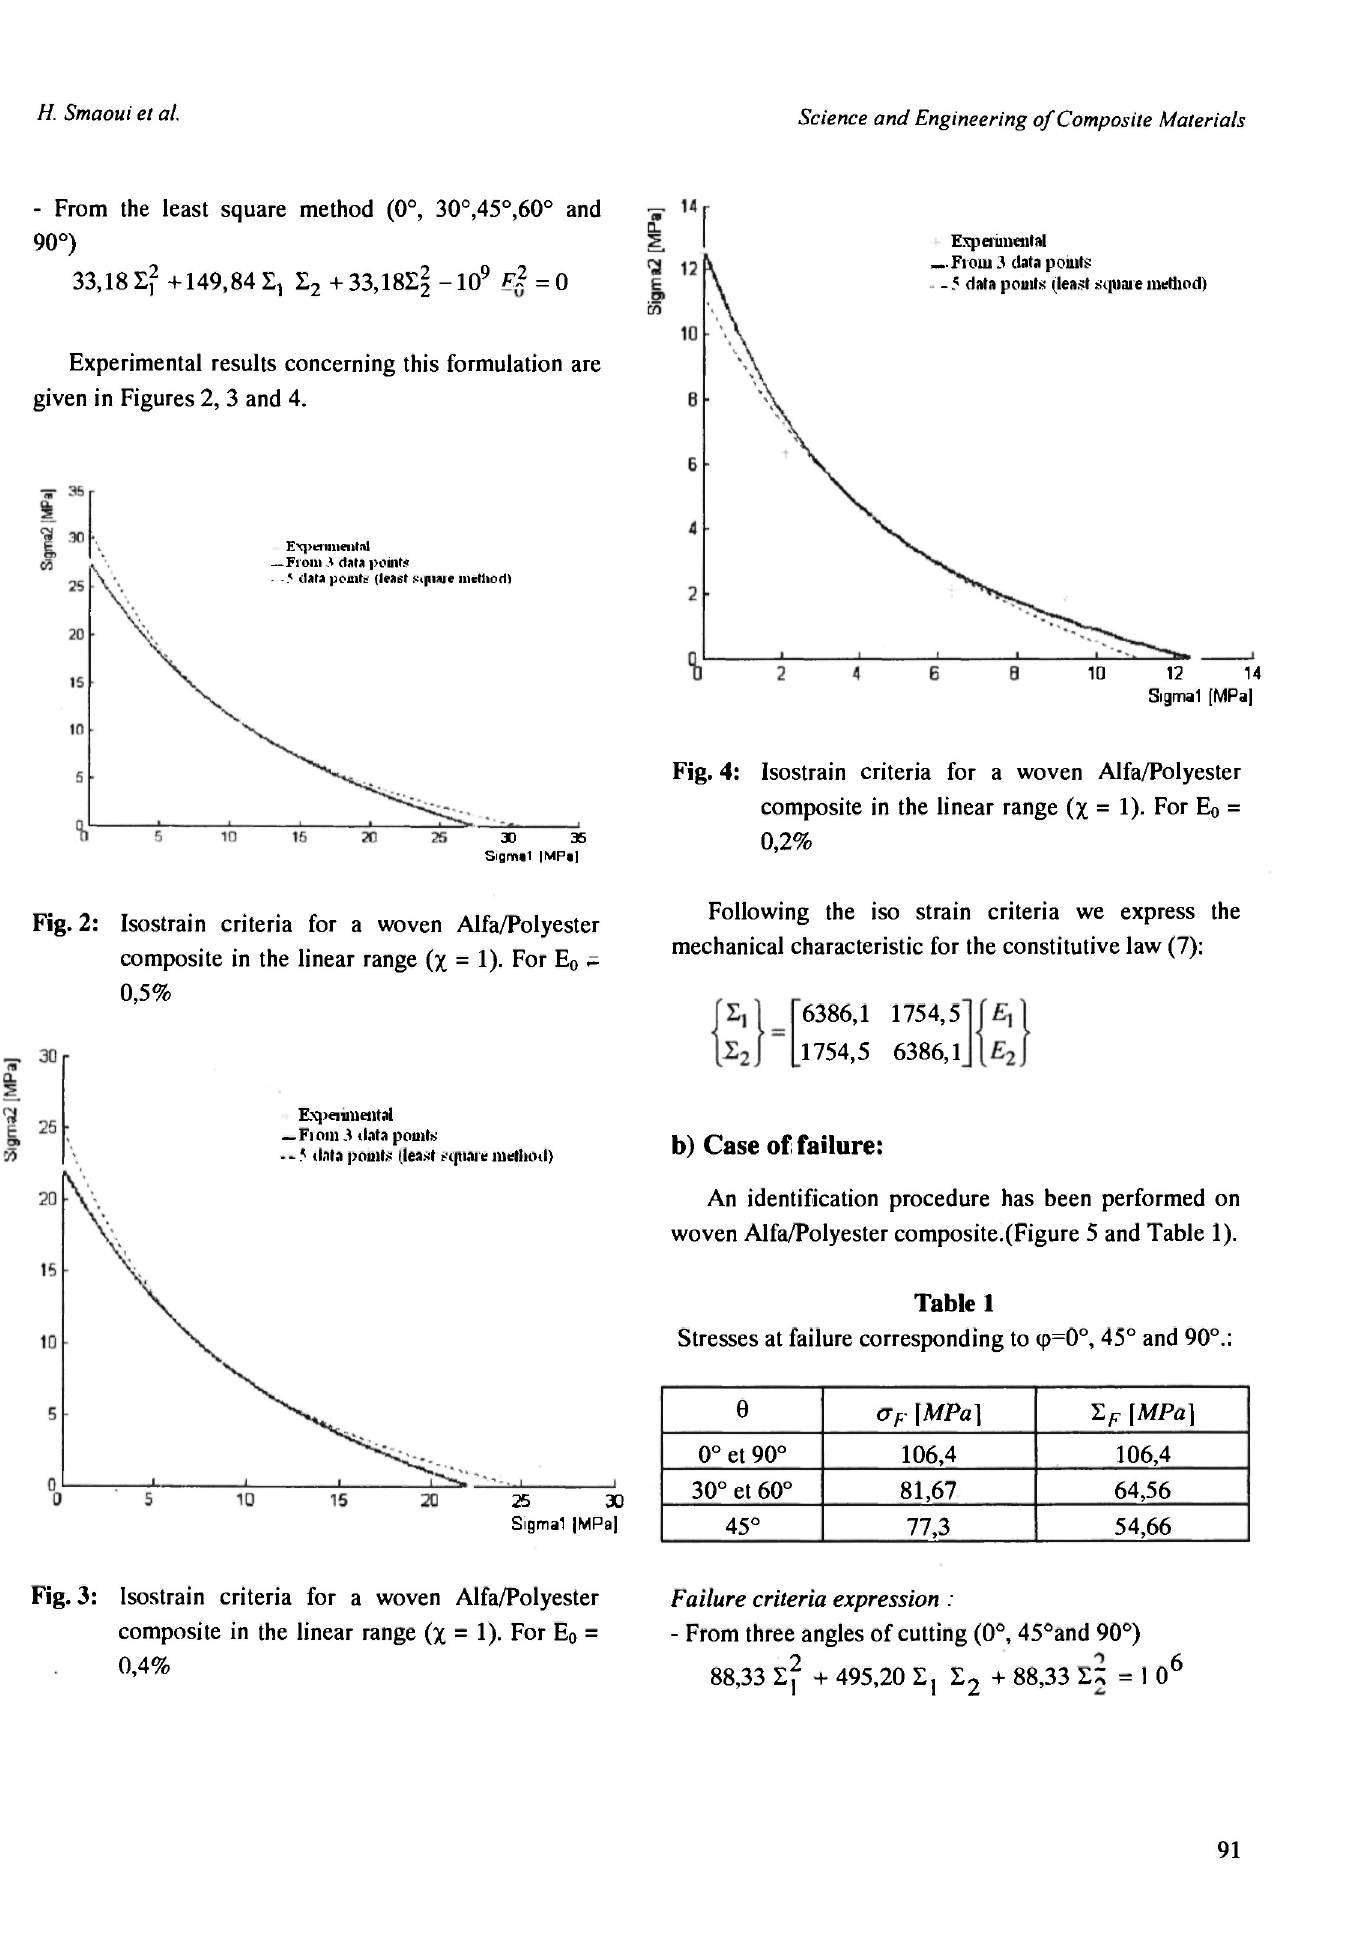
Fig. 3: Isostrain criteria for a woven Alfa/Polyester composite in the linear range (χ = 1). For E 0 = 0,4%